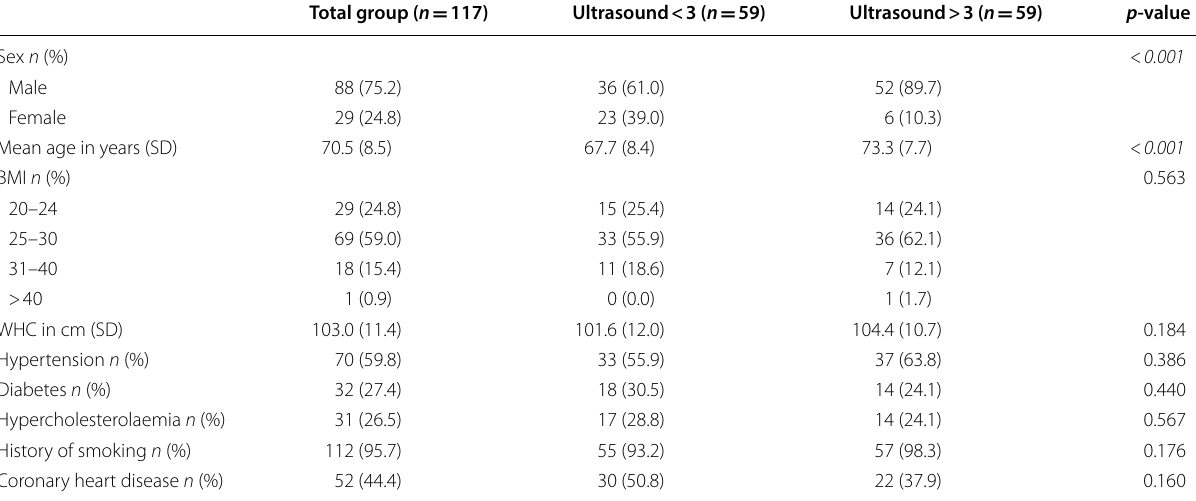
Table 1 Baseline characteristics of included patients ( N